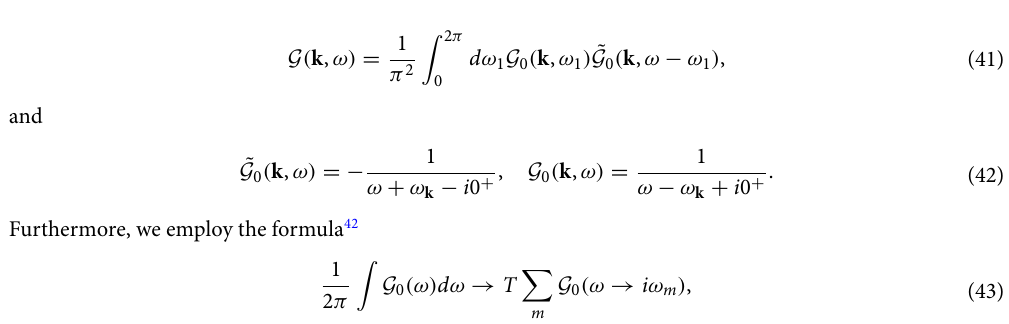
0 using SU(3) Schwinger boson theory). We perform the calculations = 0.0 and J 2 1.0 , J 0.1 , J , z , y = = − = ⊥ ⊥